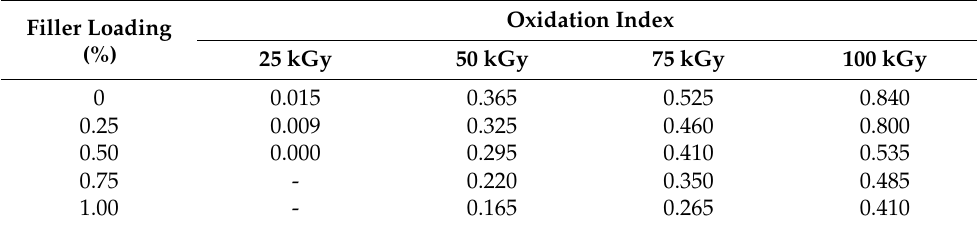
Table 1. Modification of oxidation index in HDPE against MWCNT loading at various doses [83]. Filler